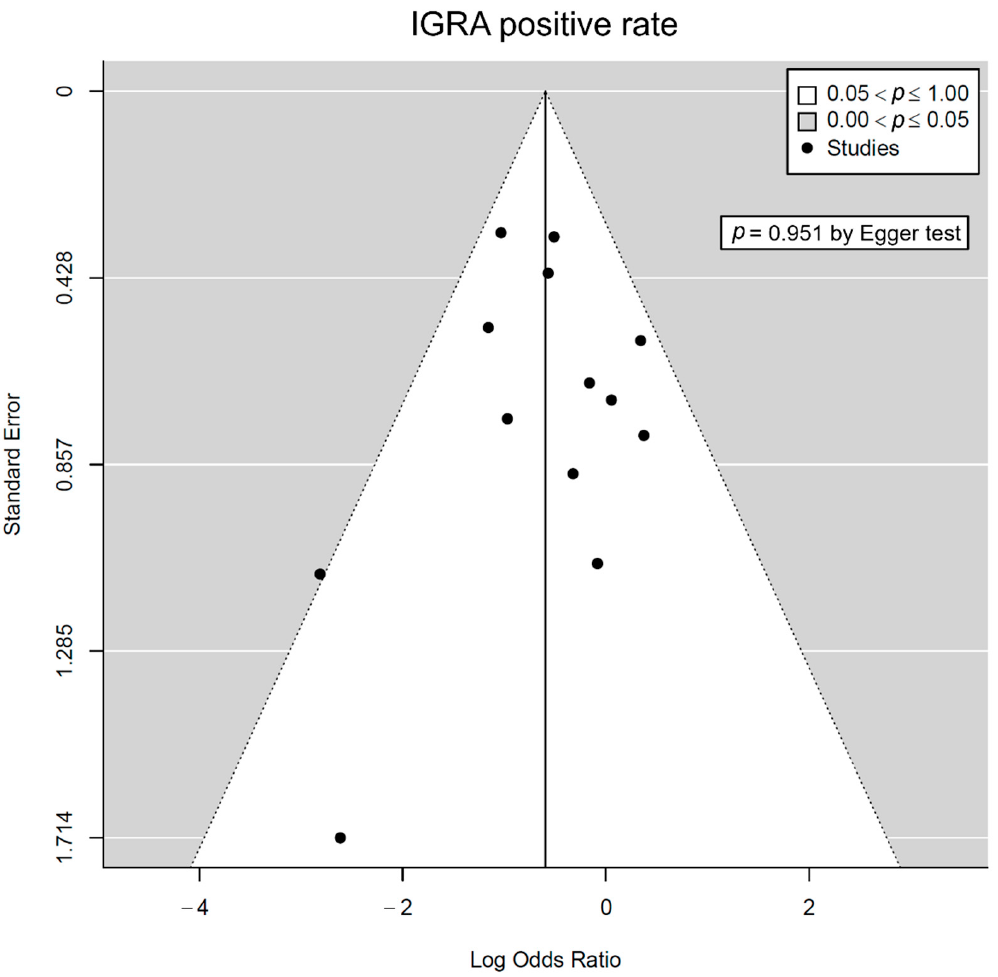
Figure 4. Funnel plots for IGRA-positive rate according to the use of IST. IGRA—interferon γ release assay; IST—immunosuppressive treatment.